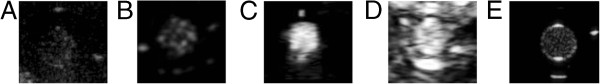
Ultrasound images of the tissue mimicking flow phantom containing Plain PVA. The images were obtained at maximum contrast to tissue ratio for each contrast sequences: A) Pulse inversion (f = 5/10 MHz, MI = 0.4), B) Pulse inversion (f = 1.5/3.1 MHz, MI = 0.4), C) Power pulse inversion (f = 1.3/2.6 MHz, MI = 1.2), D) Power modulation (f = 1.5/3.2 MHz, MI = 0.4), E) Contrast pulse sequence (f = 4 MHZ, MI = 1.0). The concentration of the CAs was 105 microbubbles/ml.